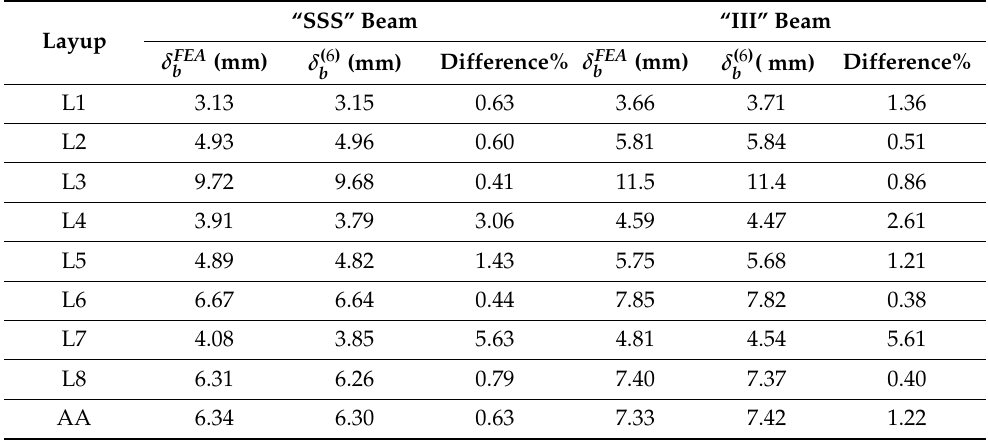
Table 3. Comparison between analytical (Equation (6)) and FEA-calculated tip deflection for the “SSS” and “III”